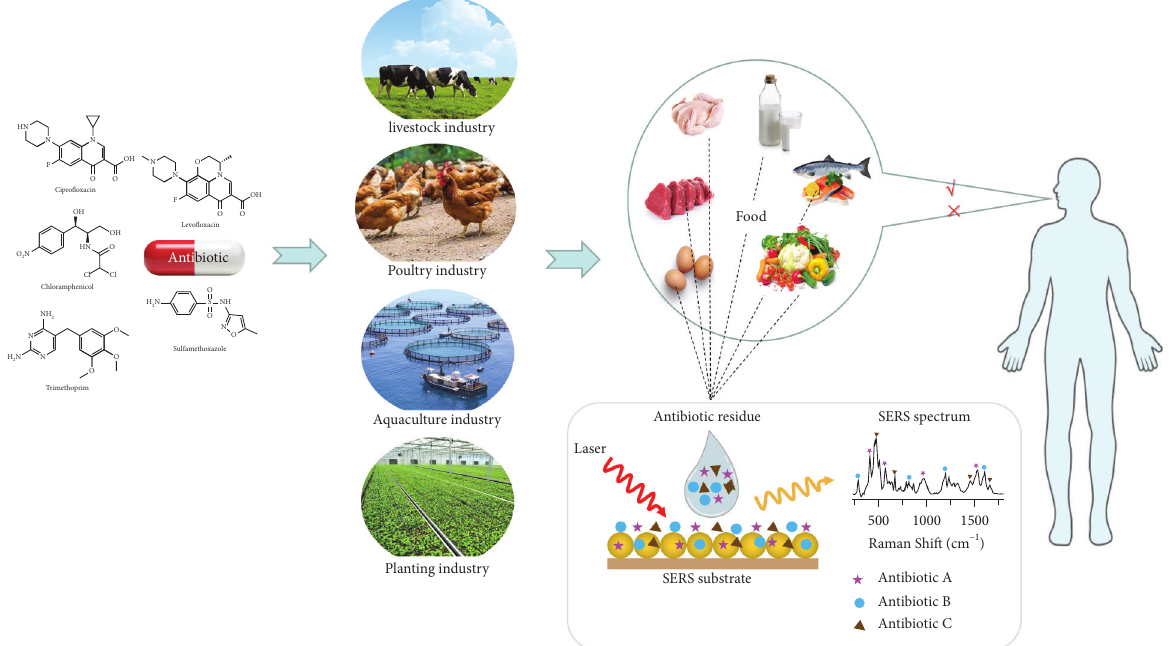
Figure 1: Schematic of the general pathway chain illustrating the use of antibiotics in farm animals/crops and the subsequent employment of SERS testing of various antibiotic-contaminated